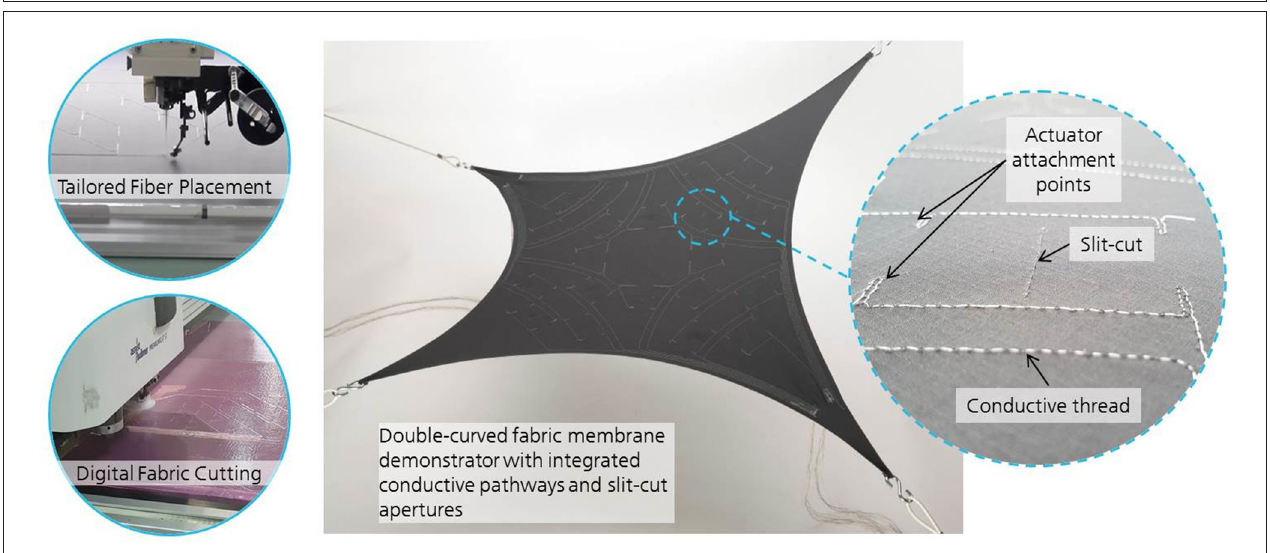
FIGURE 9 | Membrane fabric preperation: Fully automized manufacturing processes for conductor thread integration (Tailored Fiber Placement) and patterned cutting of pre-designed apertures (Digital Fabric Cutting System). attachment area during pressure-assisted curing and in many contacts by means of conductive epoxy glue applied to the cases caused a short circuit between the two actuator electrodes. electrode surfaces. The solvent-based glue, despite its low contact Tests with encapsulated and thread-contacted specimen showed resistance, diffused into the fabric and beyond the intended